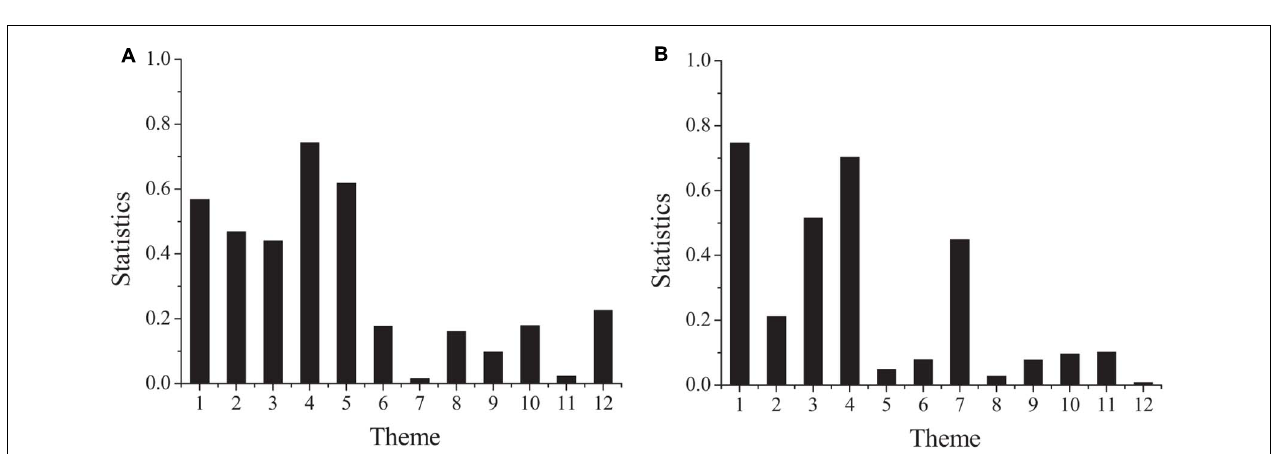
FIGURE 3 | The differences of psychological contract among employees with different educational background ( A: the second part; B: the third part).